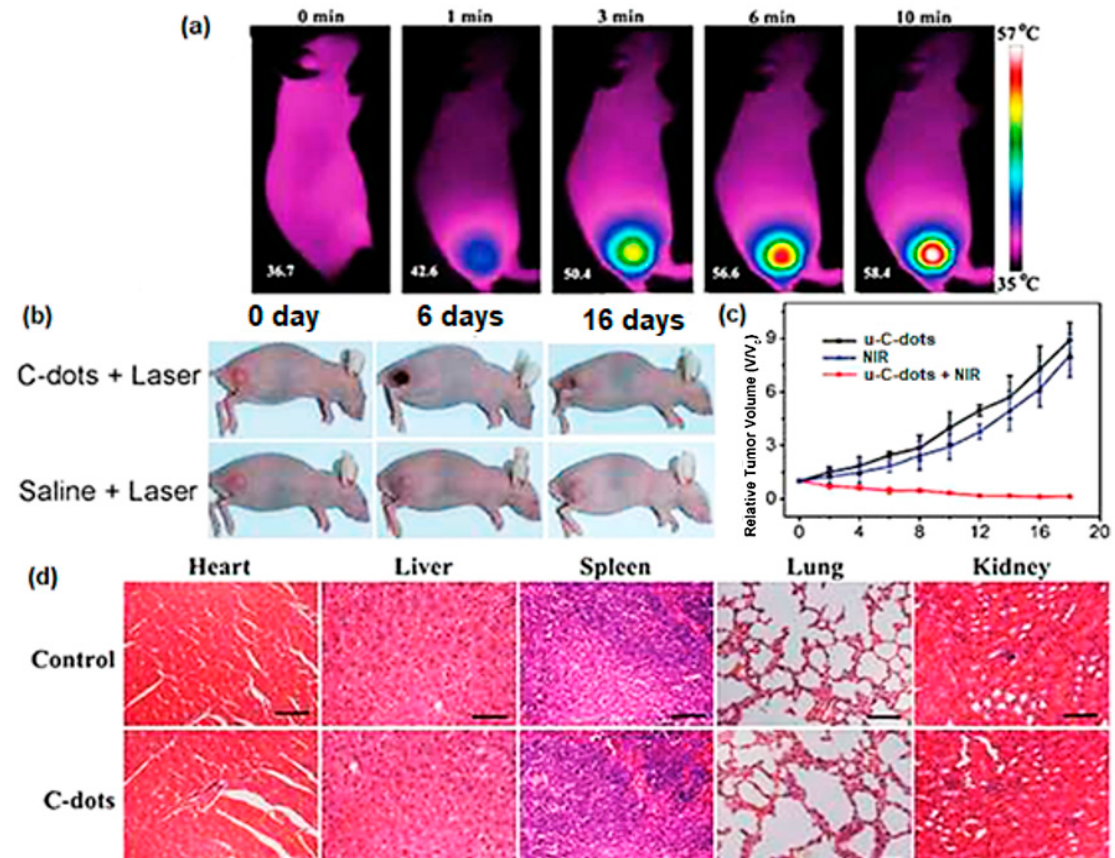
1 Figure 10. ( a ) IR images of u-C-dots injected into mice tumour locations under laser irradiation (671 nm at 2 W/cm 2 ); ( b ) photos of the mice tumours on several days after the two treatments; ( c ) relative change in the tumour volume over time during the treatments utilizing only u-C-dots, only NIR irradiation and their combination; ( d ) haematoxylin- and eosin-stained slices of the heart, liver, spleen, lung and kidney in mice after PTT. Scale bar is 50 µ m. Reprinted (adapted) with permission from [47]. Copyright 2021 John Wiley and